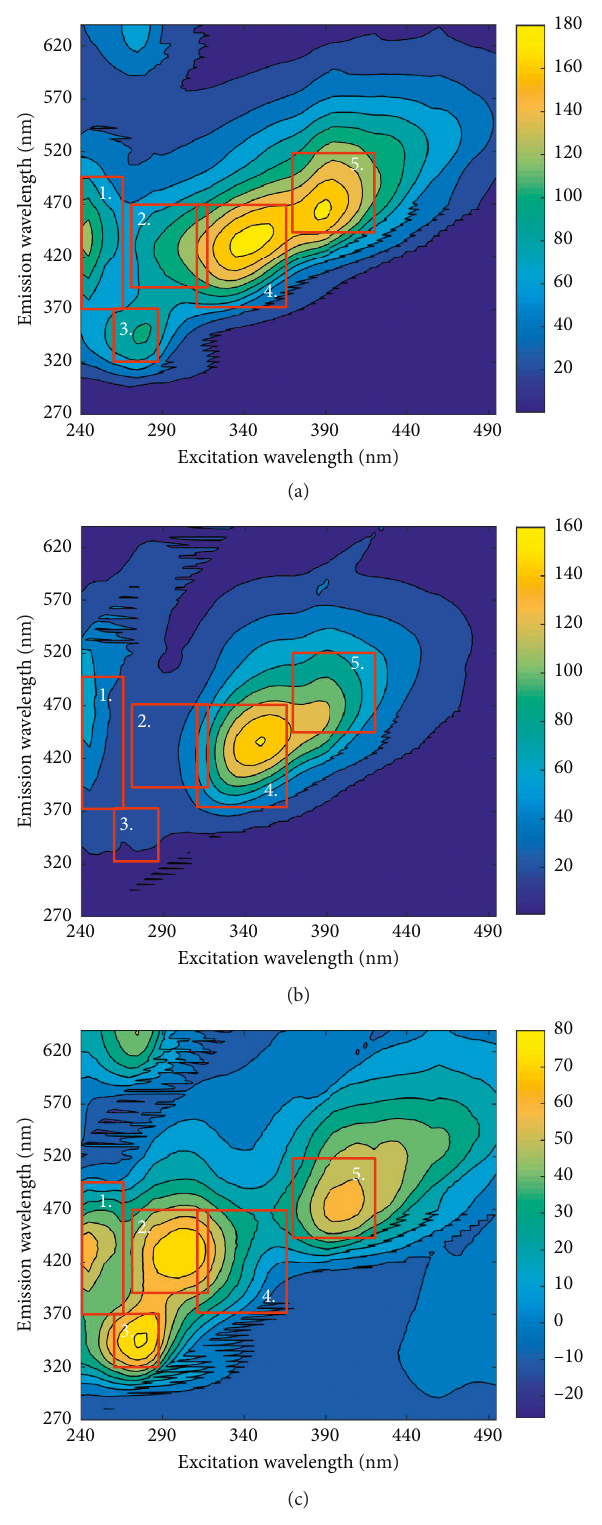
Figure 1: Fluorescence excitation-emission matrices of (a) natu- raland (b) fake honey and (c) their difference spectrum. The dis- cussedspectral regions are marked with a full line